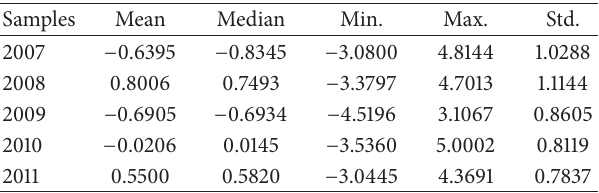
Table 3: Statistics of the population distribution of ASY values.